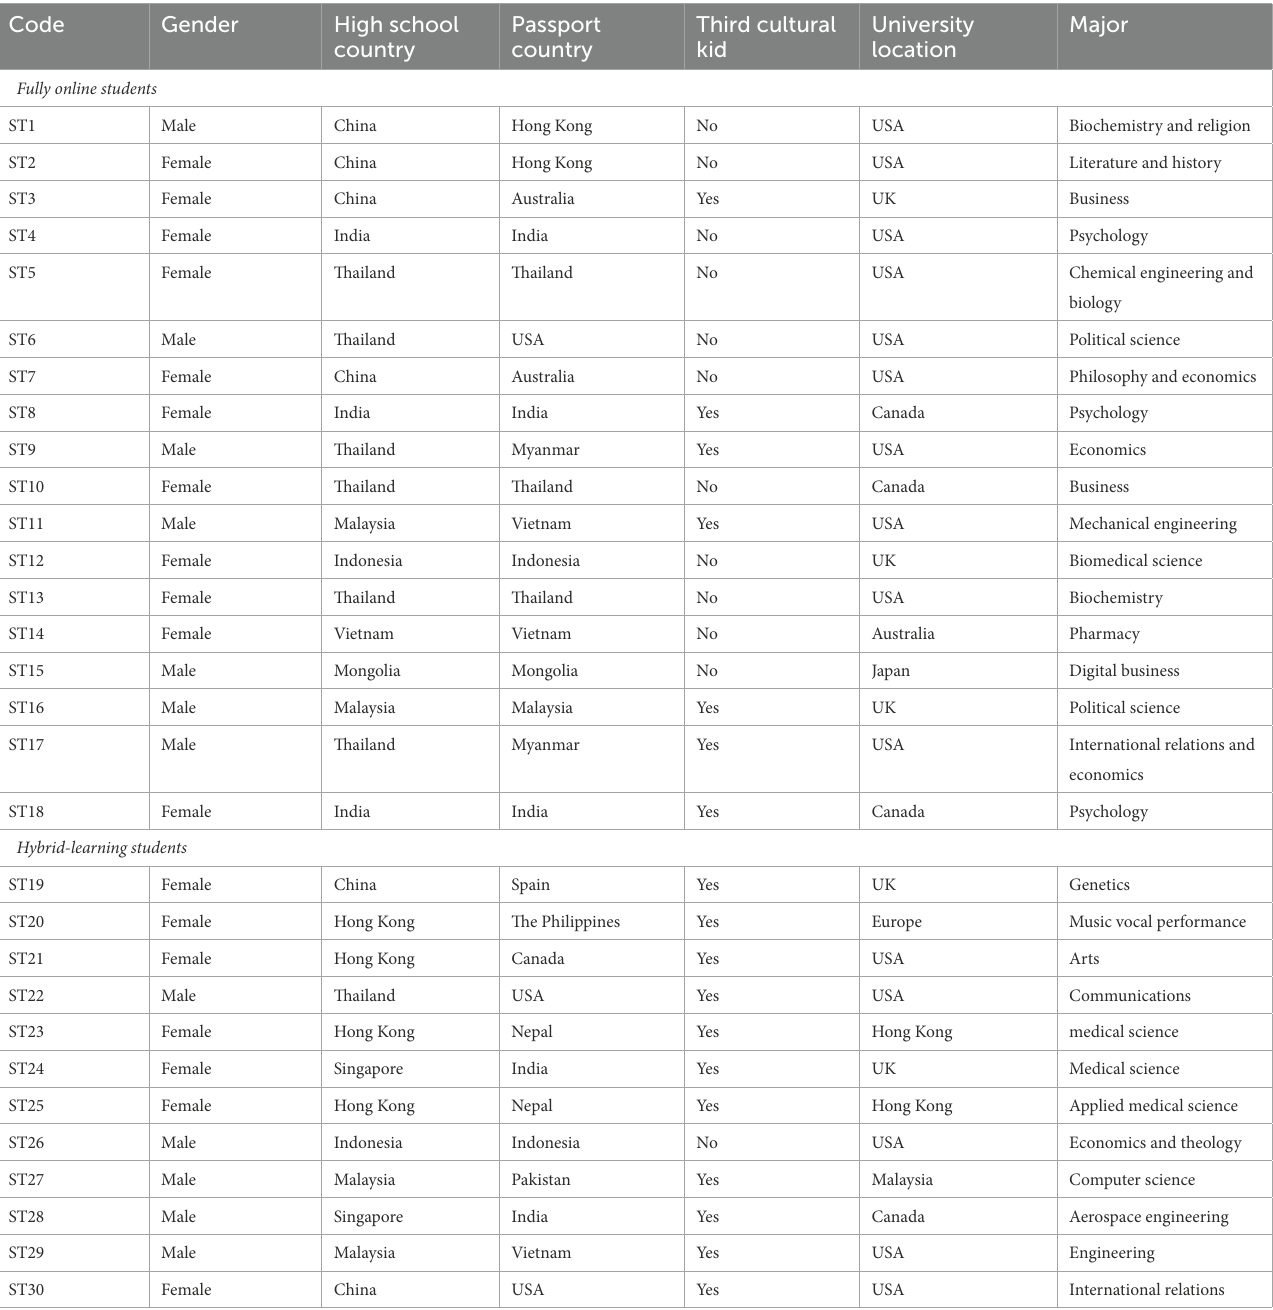
TABLE 1 Interviewee demographics.